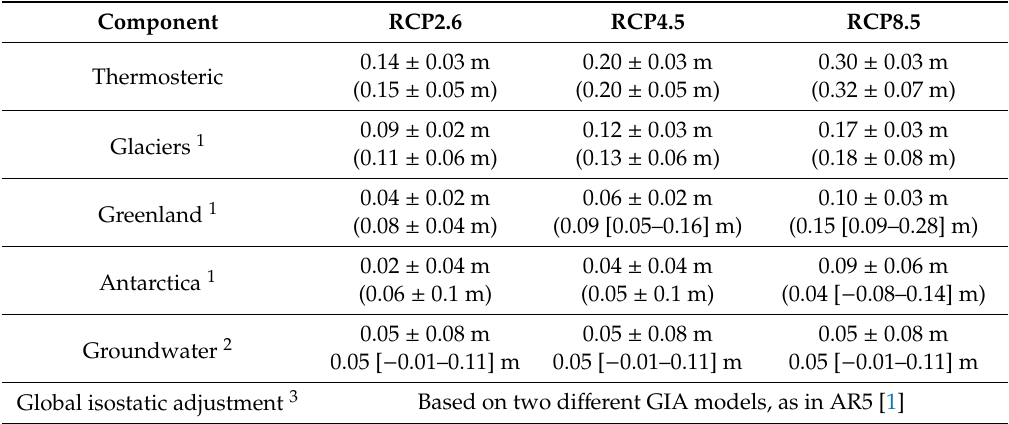
Table 2. Global mean sea-level changes by 2100 relative to 1986–2005 assumed in this study (all Gaussian distributions). For comparison, the AR5 likely range and median contributions are provided for each component in italic and parenthesis, either in the form of “(median ± half the likely range)”, or “(median [likely range])” when the distributions are not centered. All values are rounded at two significant digits beyond the decimal